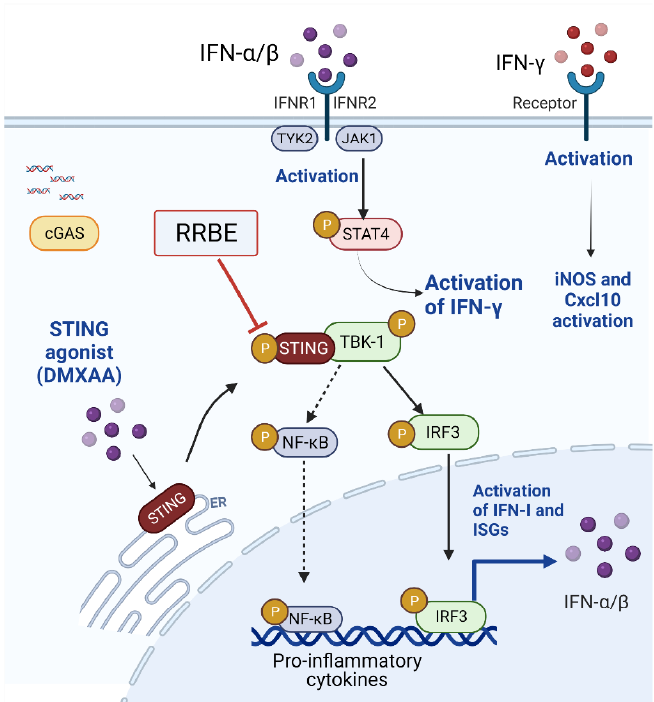
Figure 7. Schematic illustrations of RRBE ’ s effects via the STING-mediated pathway. RRBE amelio- rates IFN-I production through decreasing the phosphorylation of STING. This figure was created by Biorender.com.